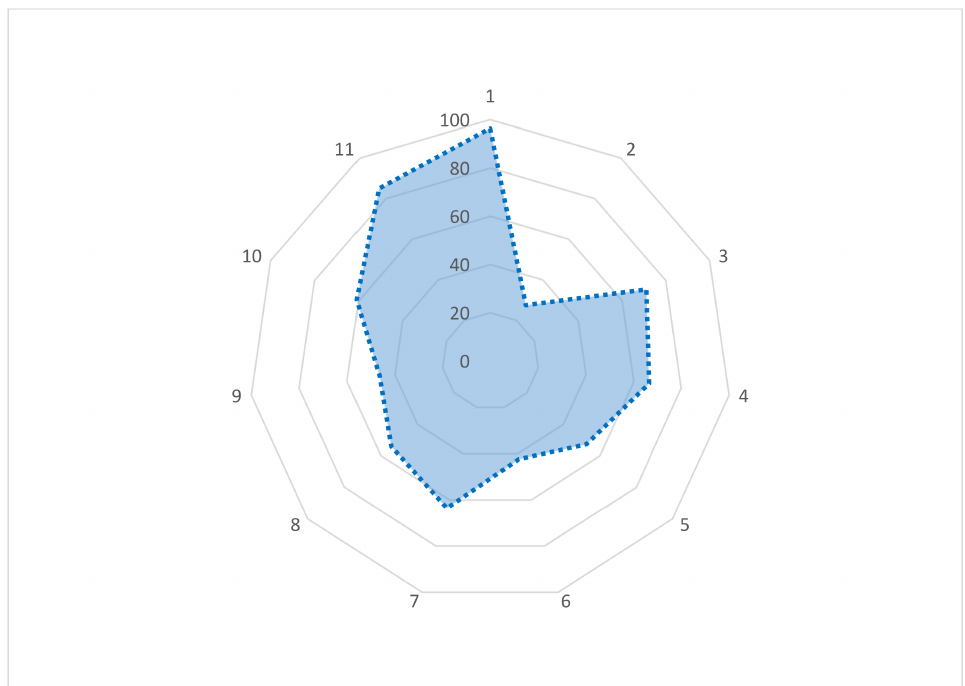
Figure 2. Radar chart of knowledge assessment of large-animal farmers’ answers to different questions in the survey questionnaire. (1) Have you heard about antibiotics? (Yes/No). (2) What do antibiotics do? (Act against bacteria/ act against virus/ act against fungus, others/act against all of the above/do not know). (3) Have you heard about antimicrobial resistance? (Yes/No). (4) What do you know about antibiotic resistance? (It causes treatment failure/it causes poor response to treatment/both/do not know/others). (5) Do you know an incomplete antibiotic course may lead to antibiotic resistance? (Yes/No). (6) Do you know an overdose/low-dose course may lead to antibiotic resistance? (Yes/No). (7) Have you heard about antibiotic residue? (Yes/No). (8) What is antibiotic residue? (Accumu- lation of antibiotics in the human body through the ingestion of meat and milk during antibiotic treatment/accumulation of antibiotics in the animal body/both/do not know). (9) Do you have any knowledge about biosecurity? (Have/do not have). (10) Have you heard about a withdrawal period of antibiotics? (Yes/No). (11) Do you know antimicrobials have some side effects?